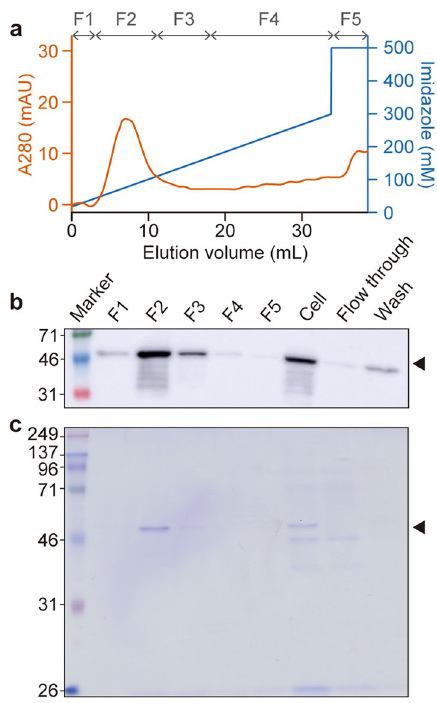
Fig. 4 Purification of rGFP-PDL1scFv. a Chromatogram of protein elution. Protein adsorbed on a His-Trap column was eluted by adding imidazole. The eluted protein was collected as five fractions (F1–F5) based on A 280 . b The presence of rGFP-PDL1scFv in each fraction was analyzed by WB using an anti-His-tag antibody. c Results of SDS-PAGE (CBB staining) analysis. The black arrow indicates the band corresponding to the size of rGFP-PDL1scFv (59.0